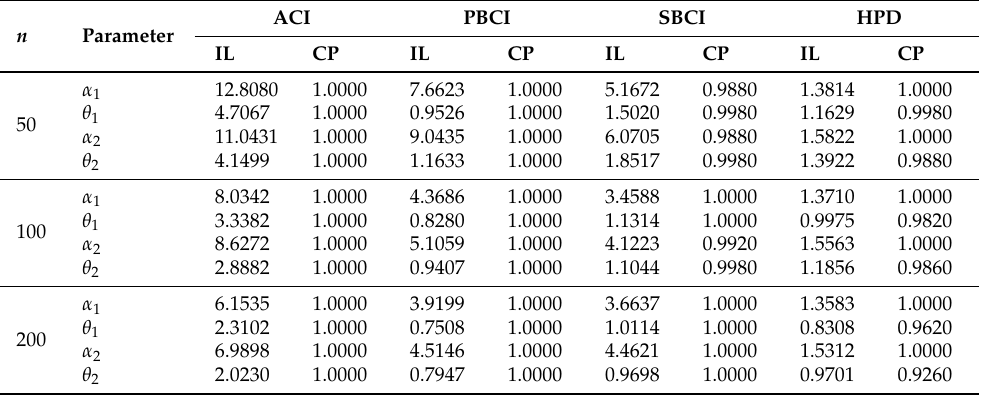
Table 5. Interval estimates of ( α t , θ t ) , t = 1,2 under Scheme